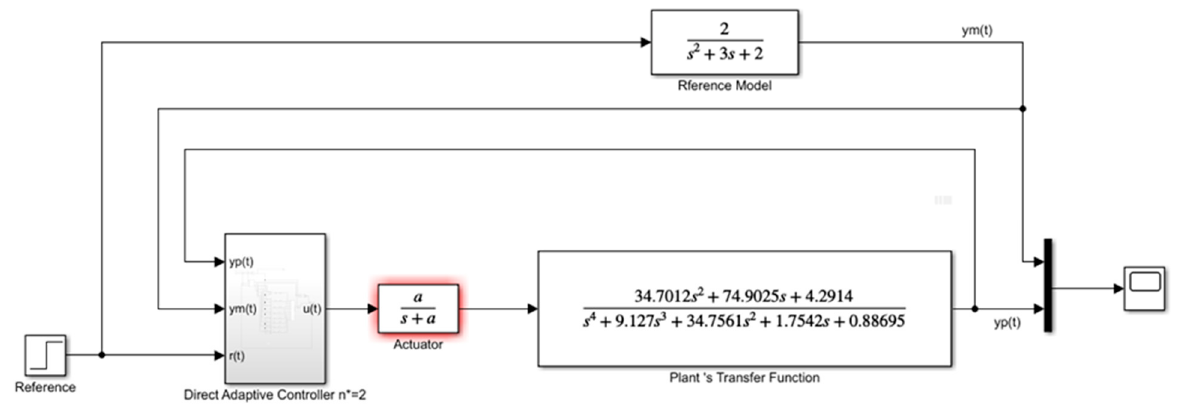
Figure 3. Detailed block diagram of the DMRAC applied to the plane.